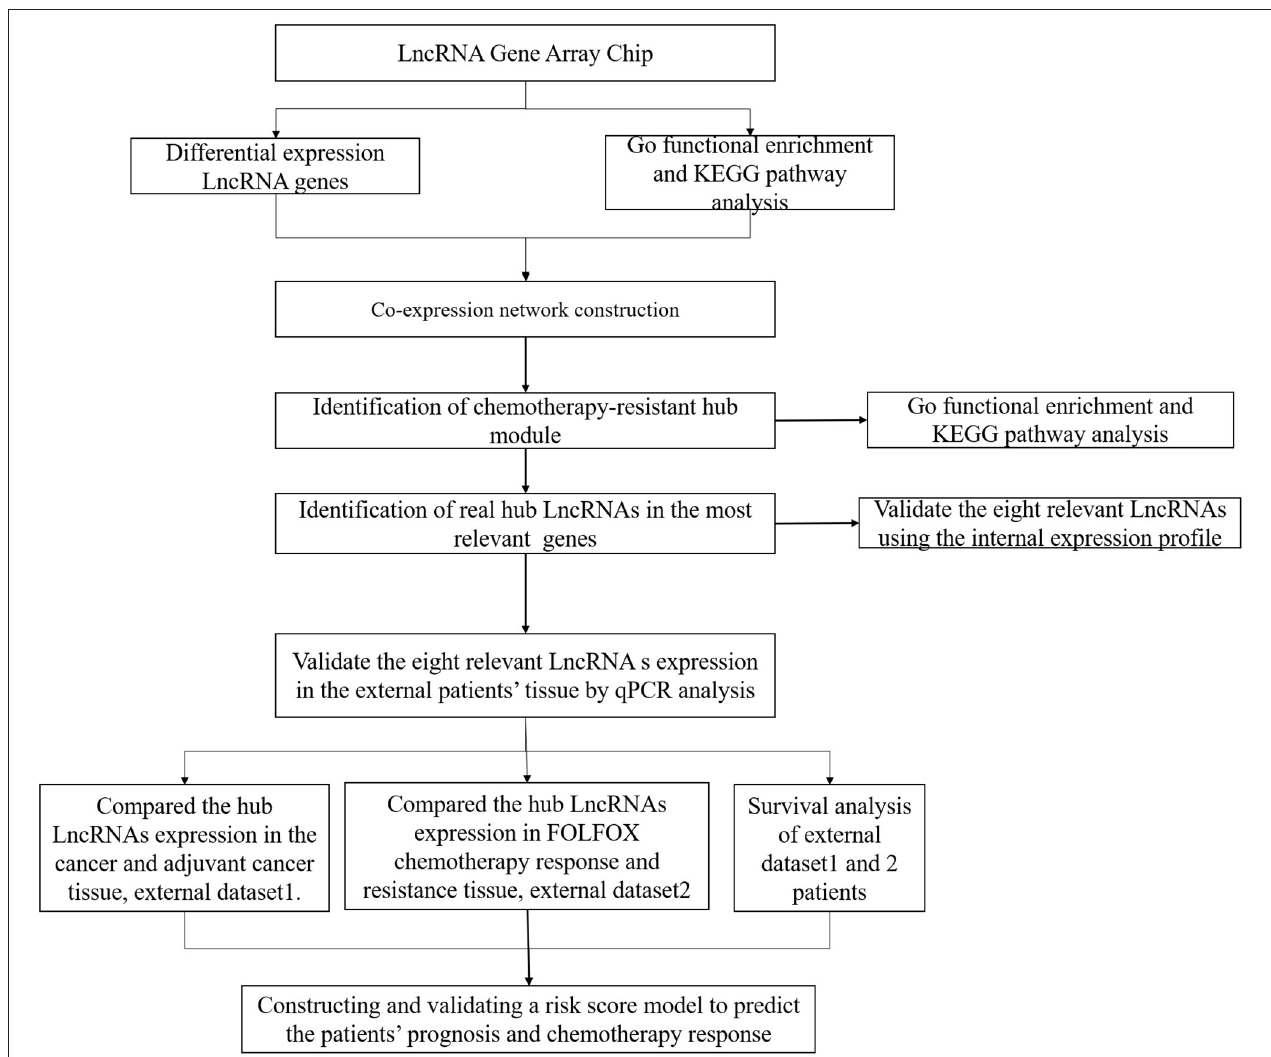
FIGURE 1 | Workflow diagram in this